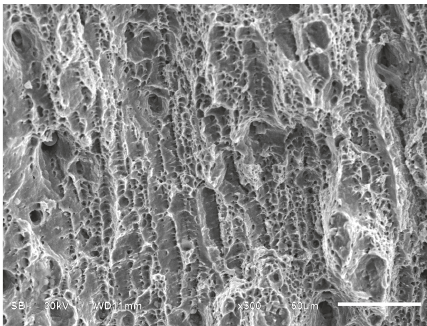
Figure 3: Fracture morphology of 4340 steel in 100 ∘ C deaerated distilled water.